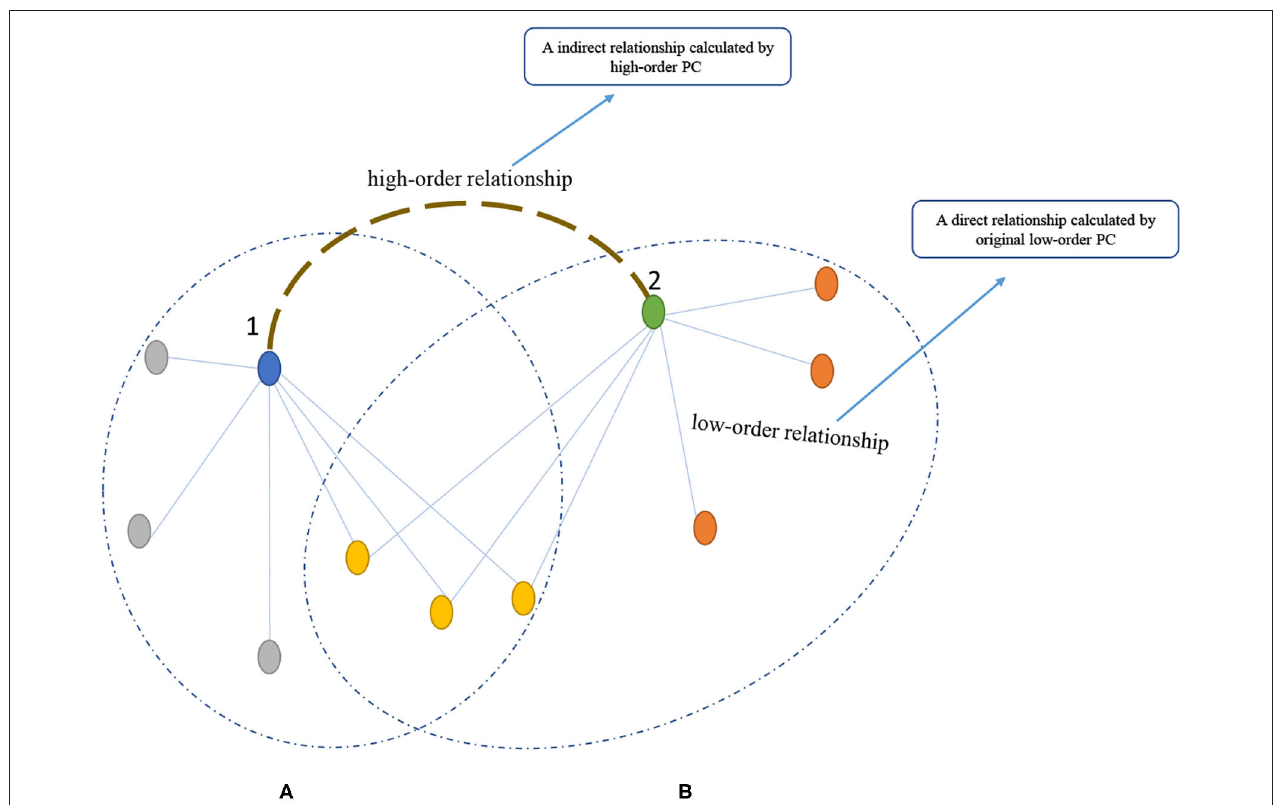
FIGURE 1 | An analogy of PC 2 to a friendship network. The (A,B) are the friendship networks of nodes 1 and 2, respectively.